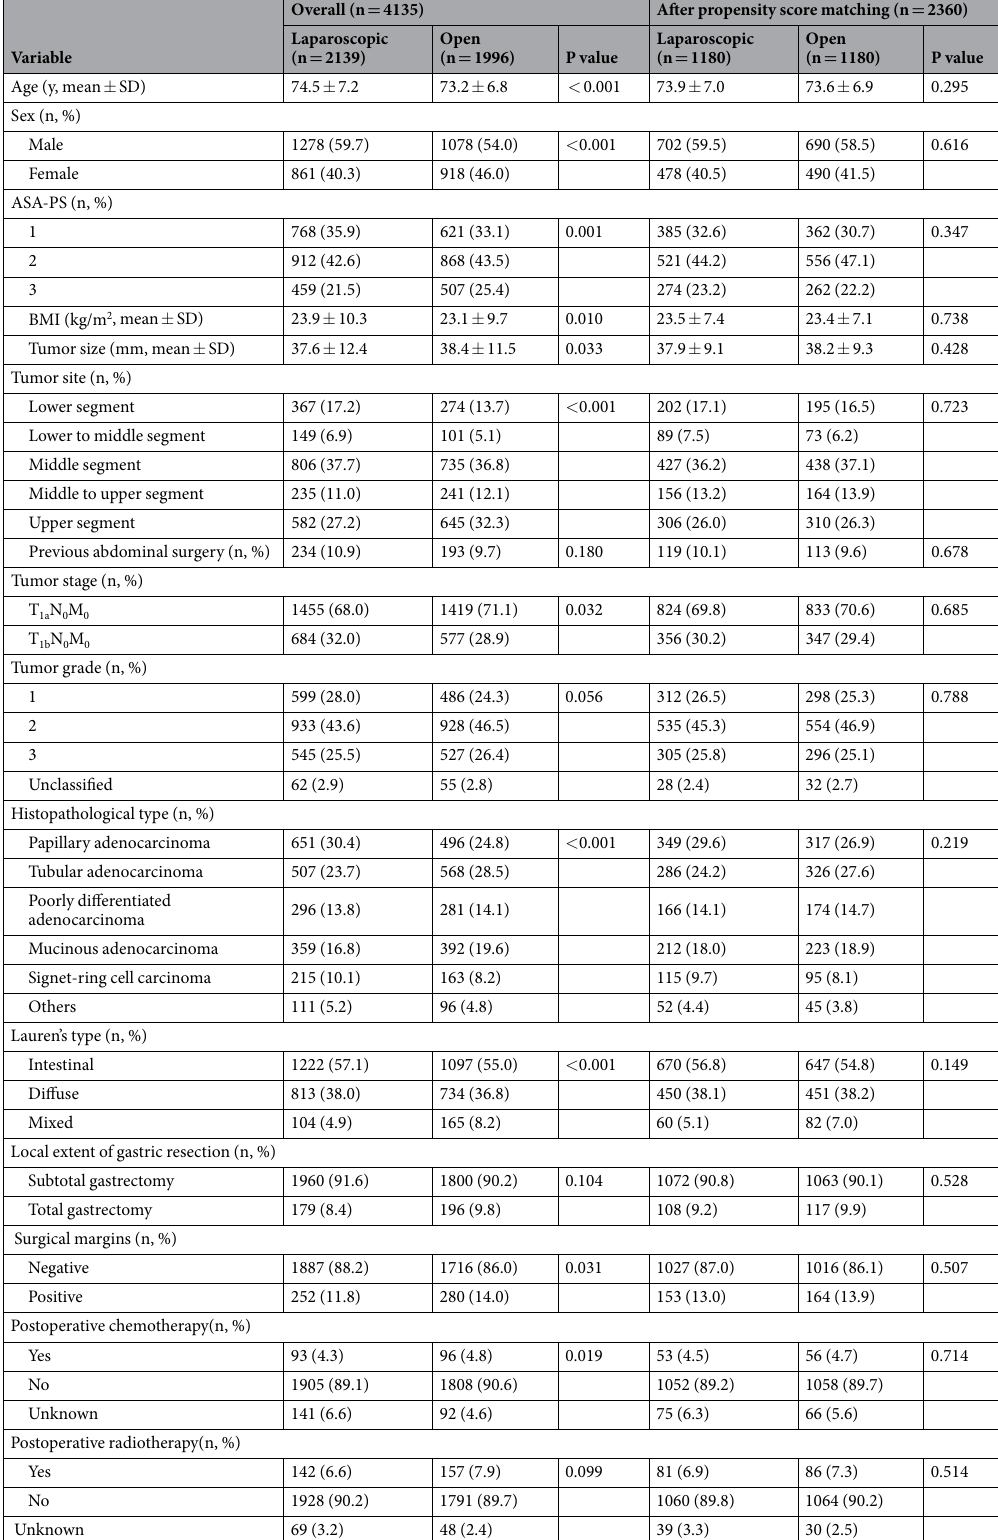
Table 1. Baseline demographics before and after propensity score matching. ASA-PS, American Society of Anesthesiologists physical status; BMI, body mass index; SD, standard